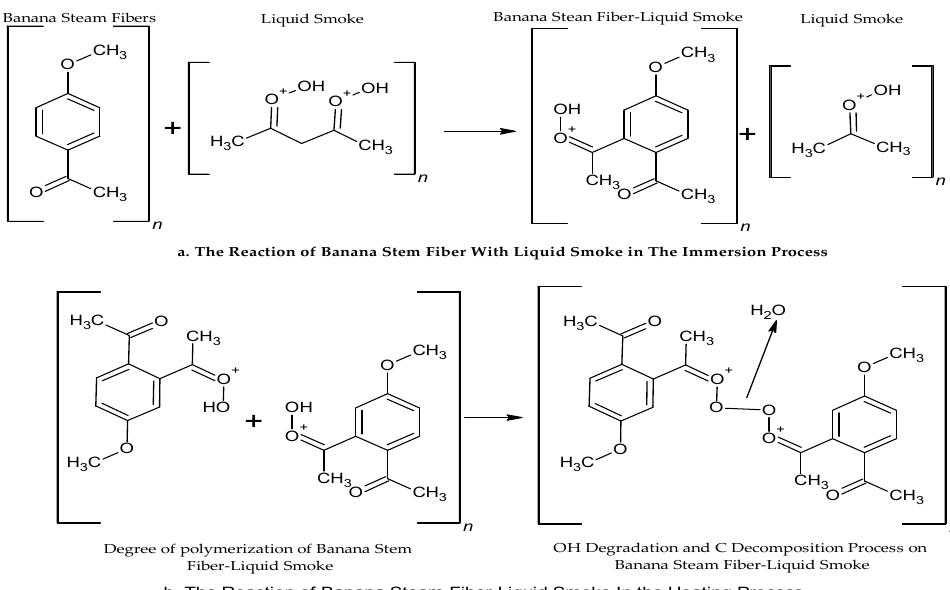
Figure 1. The reaction process of banana stem fiber with liquid smoke.